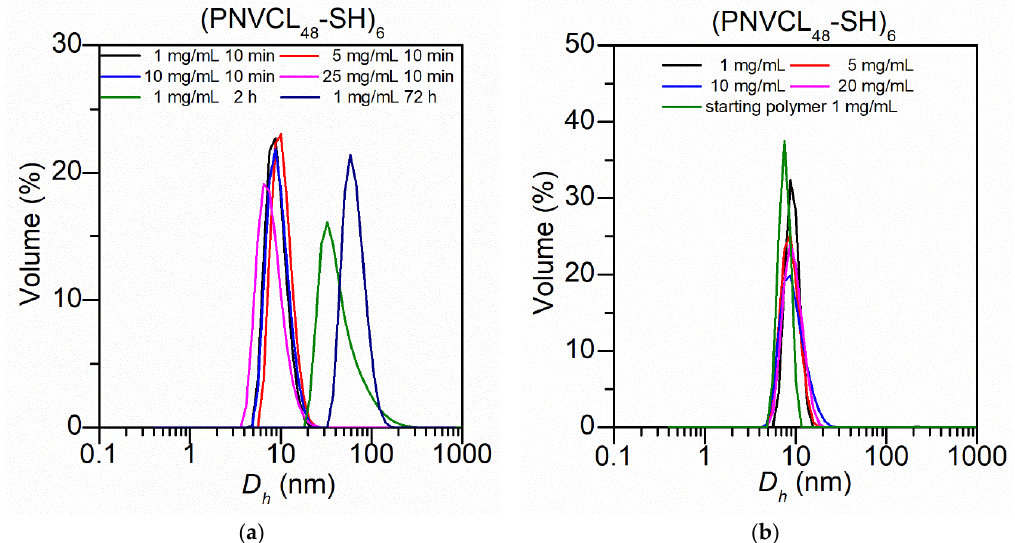
Figure 4. DLS measurements. Evolution of the D h of the (PNVCL 48 -SH) 6 star polymers in ( a ) THF and ( b ) H 2 O.